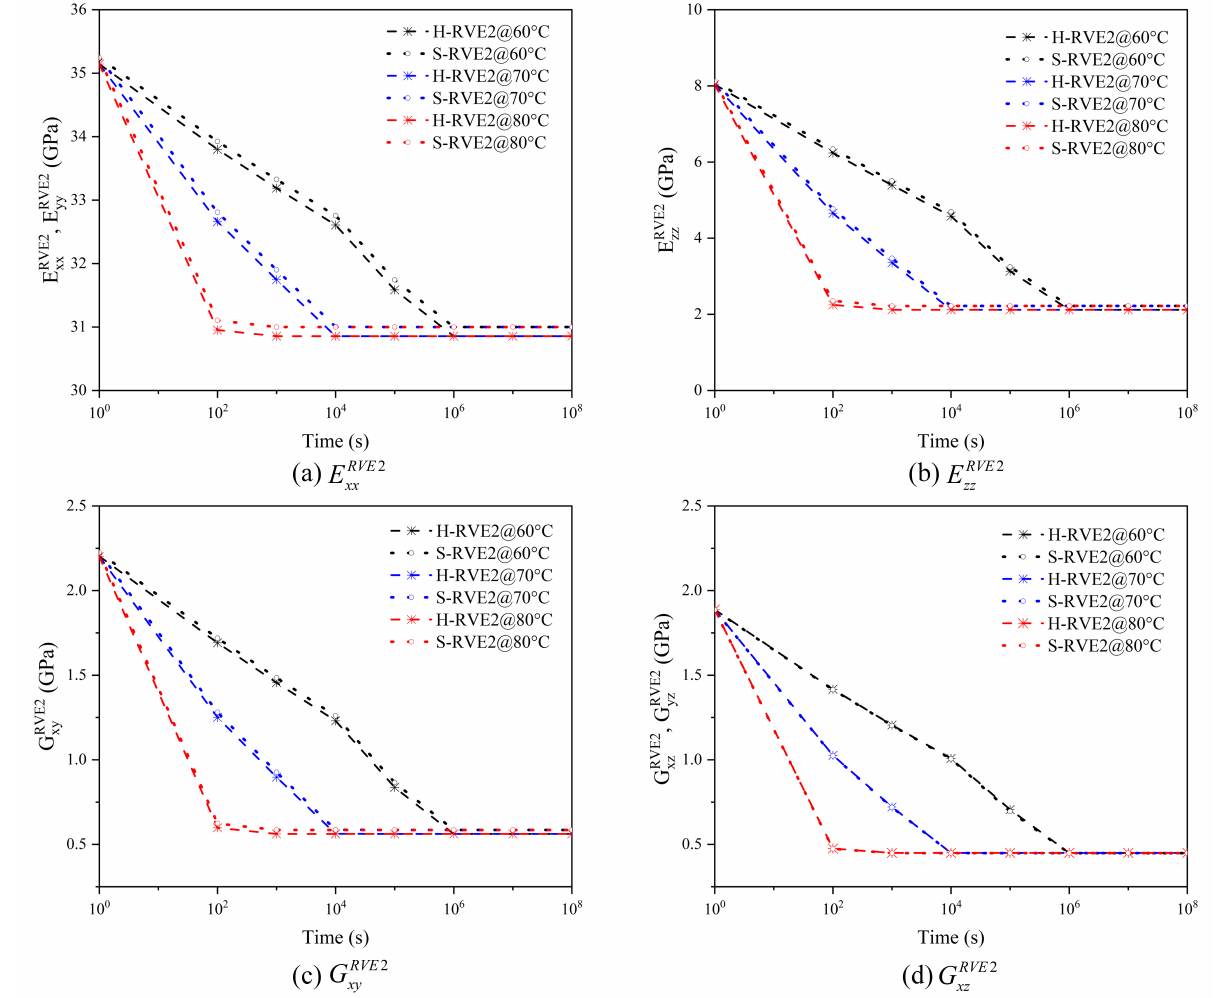
Figure 9.Figure 9. Effect of temperature on the effective relaxation modulus of 2D woven